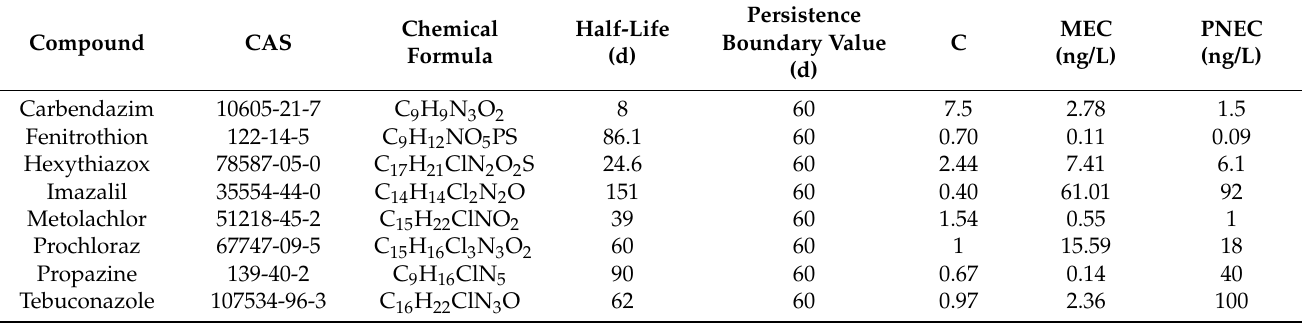
Table 1. Basic data of pesticide residues in the Ebro River.